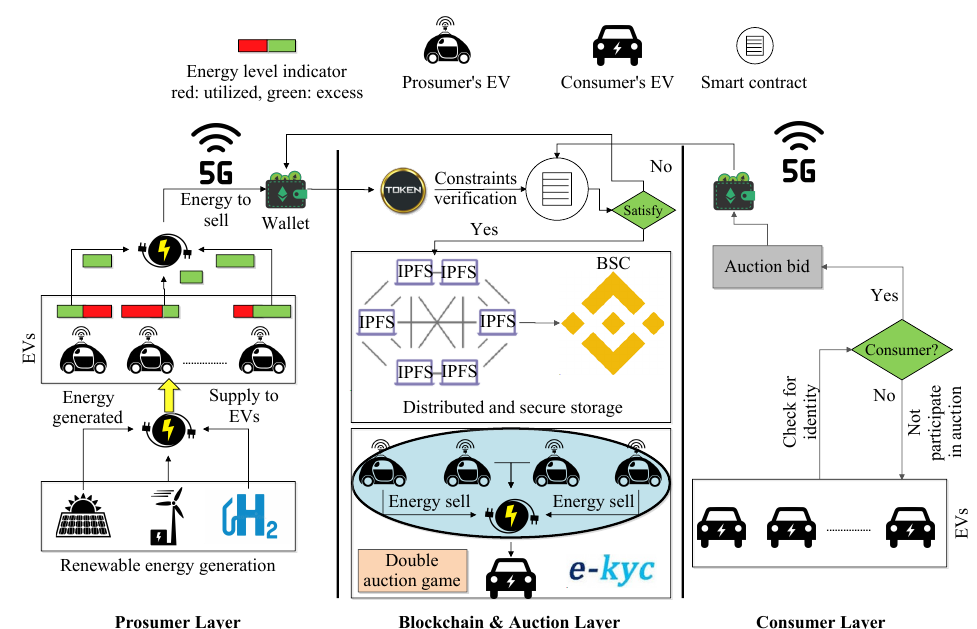
Figure 3. The three-layered architecture of the proposed